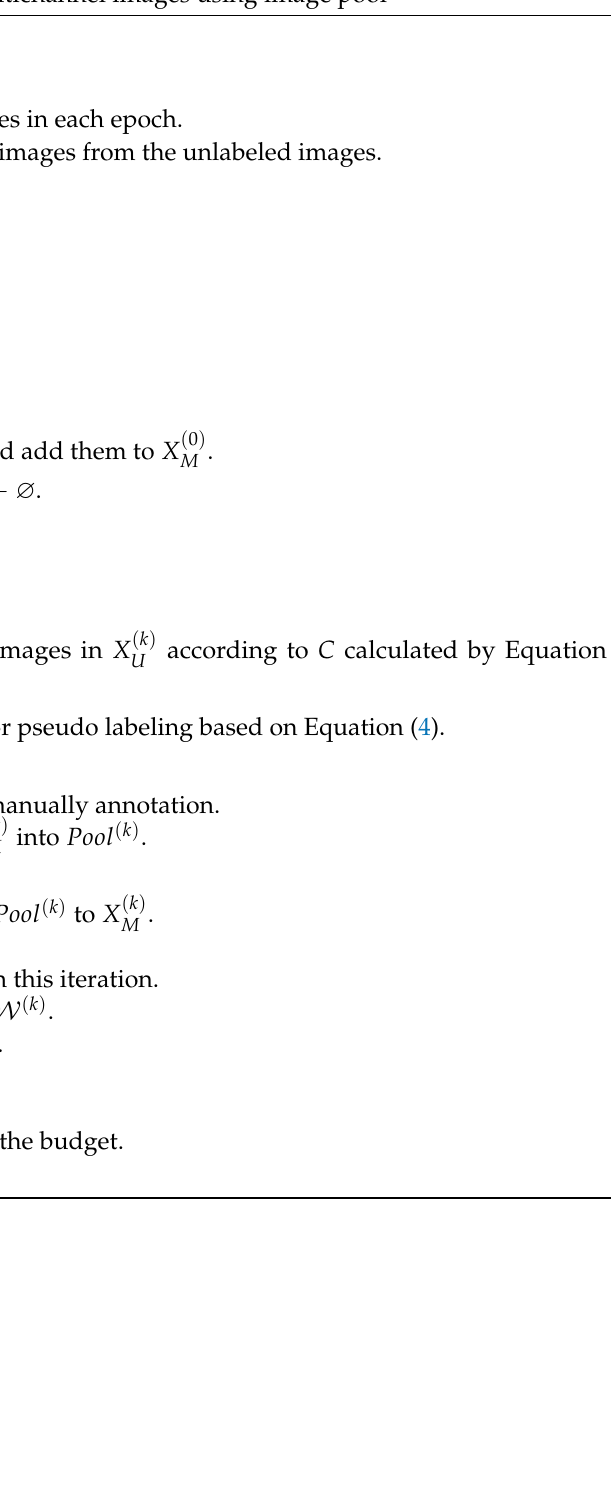
Algorithm 2 Active deep learning for multichannel images using image